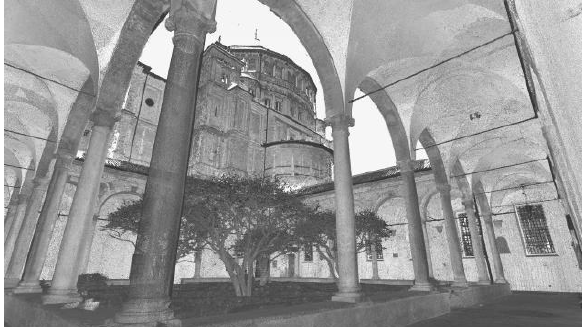
Figure 3. Point cloud of the Cloister of the Frogs, acquired by the Leica HDS 7000 laser